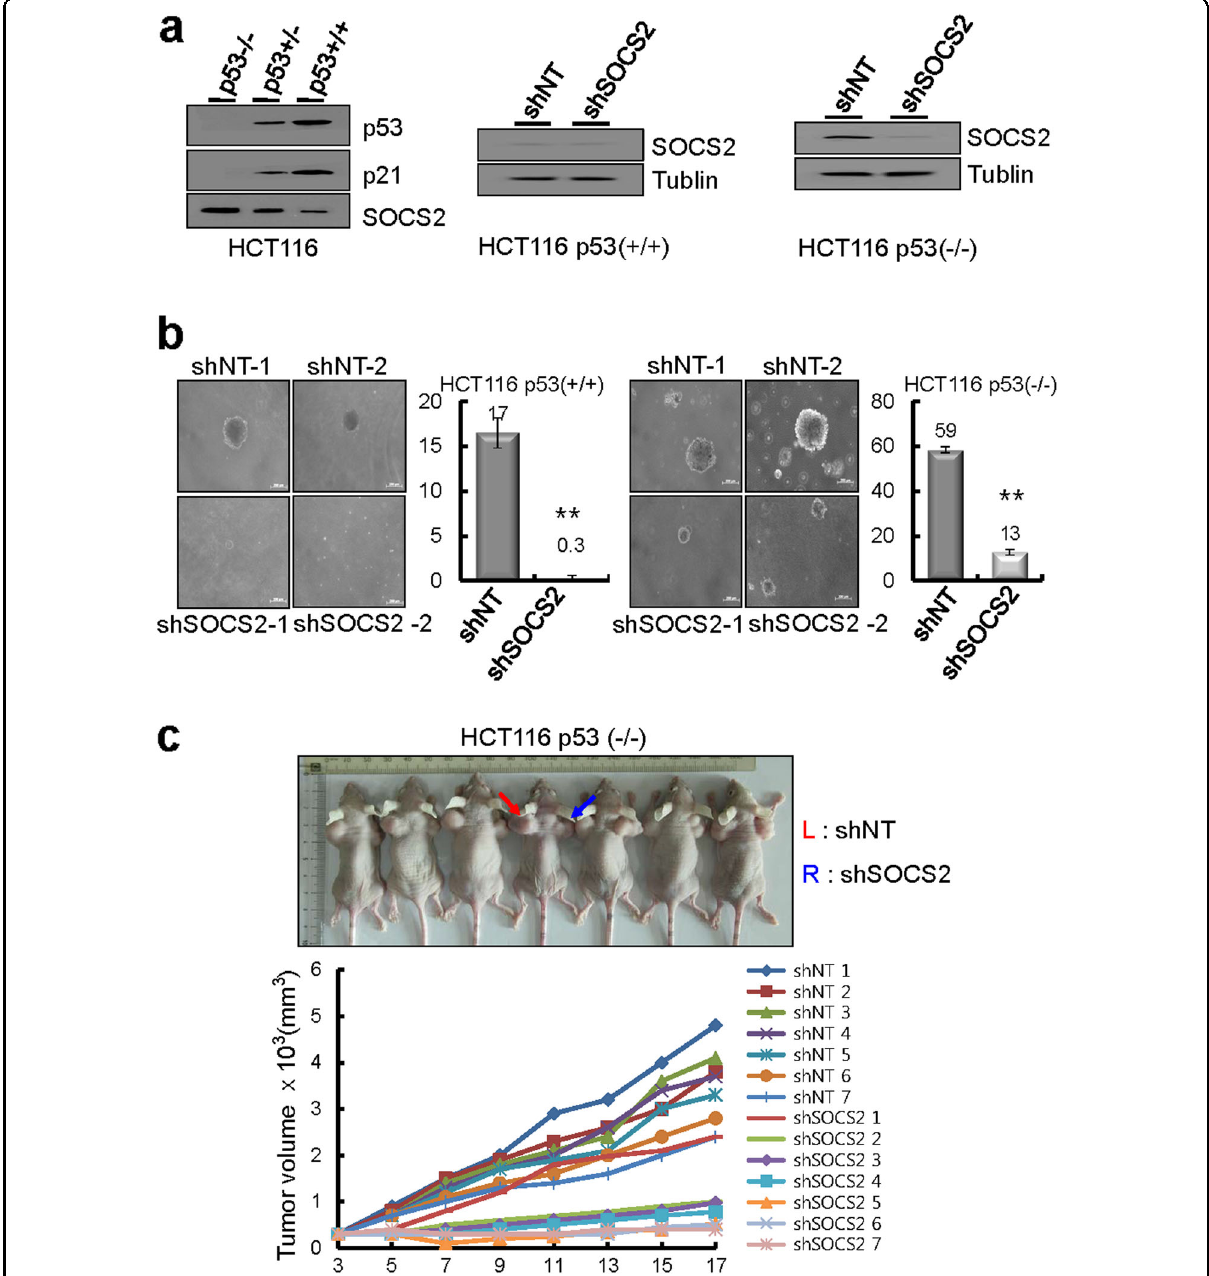
Fig. 3 Inhibition of tumor growth by SOCS2 knockdown in p53-null cells. a Immunoblots from the extracts of colon cancer cells transduced with lentiviral particle encoding SOCS2 shRNA. b Colony formation after SOCS2 knockdown in HCT116 cells. Values represent the mean ± SD from three independent experiments. ** P < 0.01. c Tumorigenicity after SOCS2 knockdown. Tumor cells transduced with lentiviral particle encoding SOCS2 shRNA were inoculated into right shoulders of mice and compared with inoculation of nontarget tumor cells into left shoulders ( n = 10, ** P < 0.01). Tumor growth measured at indicated times (lower panel). Values represent the mean ± SD from three independent experiments. ** P <